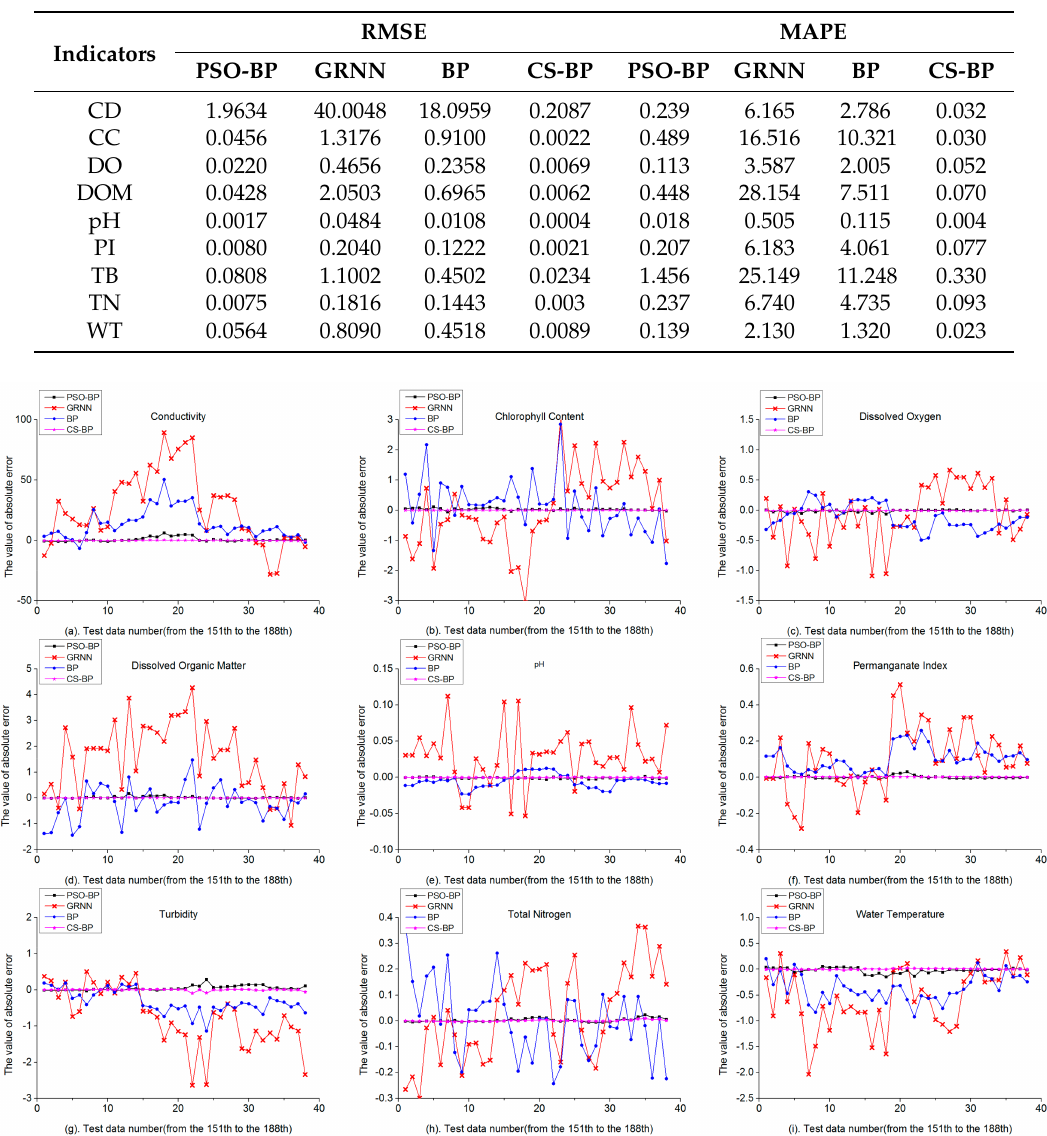
Figure 5. The absolute errors of water quality indicators of four models in Scenario